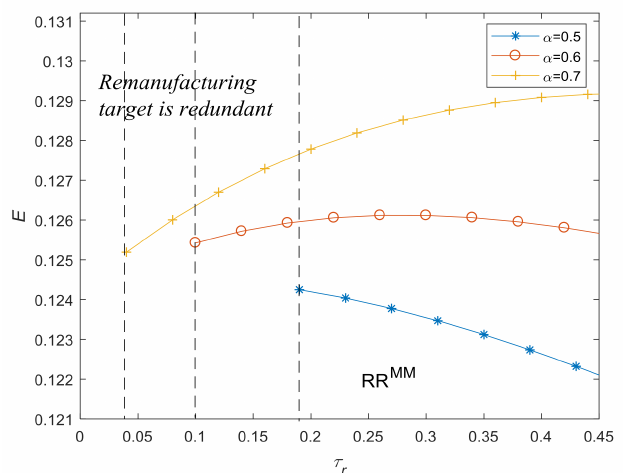
Figure 8. Environmental impact with respect to τ r and α